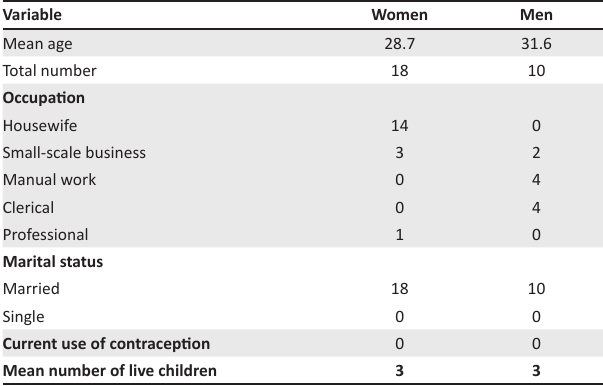
TABLE 1: Baseline characteristics of study participants.